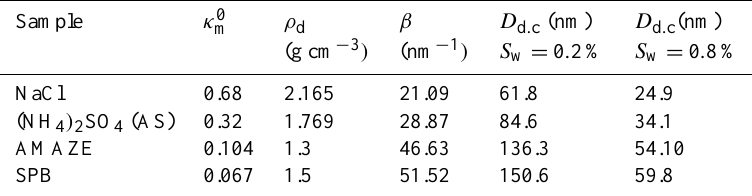
Table 6. CCN parameters for the reference salt samples (NaCl, (NH 4 ) 2 SO 4 ) and for the atmospheric aerosol samples (AMAZE, SPB). κ 0 m ( = k 6 ) is the dilute hygroscopicity parameter (Eq. 44), ρ d is the particle density, β is the scaling parameter and D d , c is the dry activation diameter calculated from Eq. (15) for water vapor supersaturations ( S w ) of 0.2% and